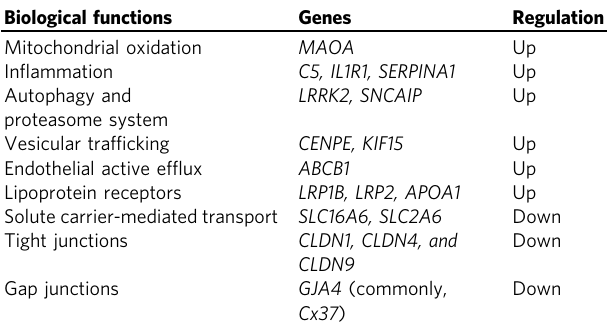
Table 1 Identi fi cation of multiple genes in the α Syn fi brils condition implicated in a variety of cellular